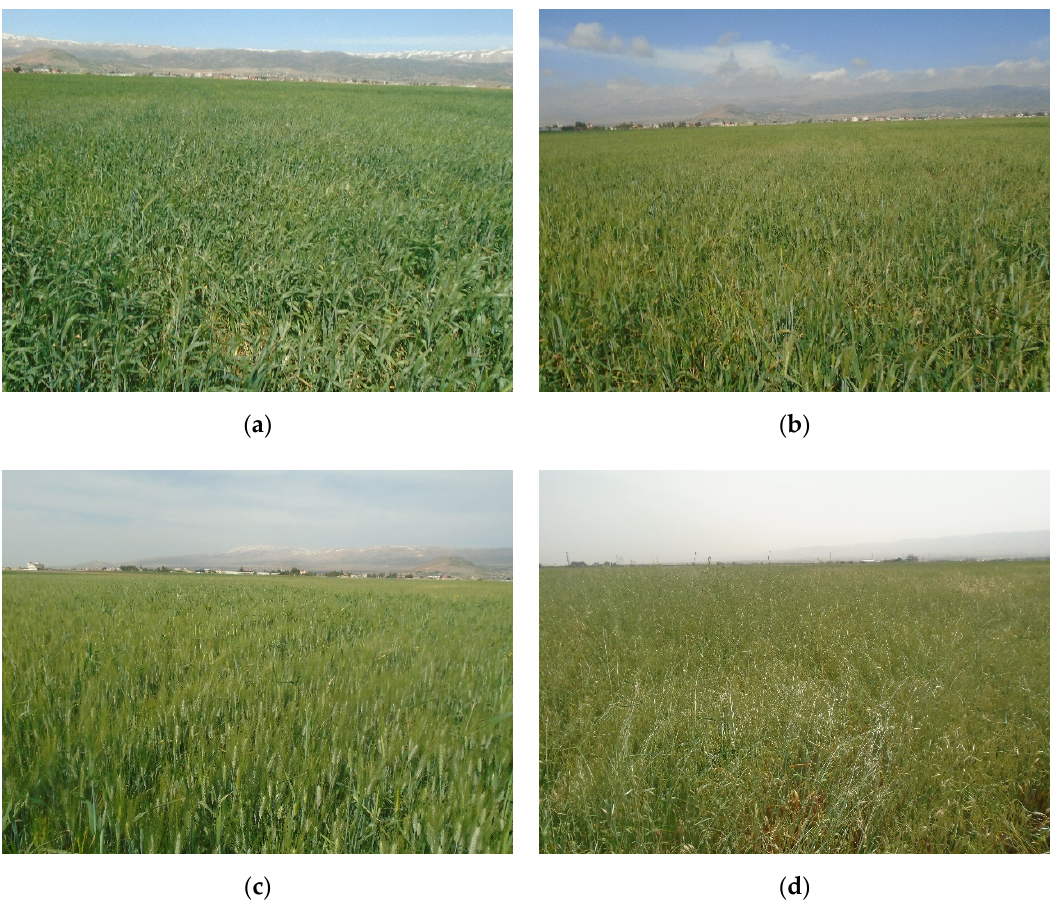
Figure 4 . Crop height and LAI field sampling at different growing stages of a wheat culture studied during the 2019 growing season: ( a ) DOY: 122, LAI: 2.3, height: 45 cm, ( b ) DOY: 131, LAI: 2.97, height: 73 cm, ( c ) DOY: 138, LAI: 3.03, height: 78 cm, ( d ) DOY: 141, LAI: 3.23, height: 58 cm.